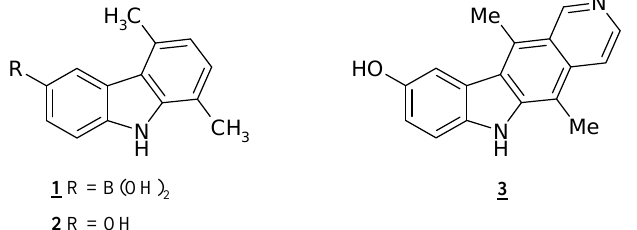
Figure 1 . Carbazol-3-yl boronic acid 1 , its 3-hydroxy derivative 2 and hydroxyellipticine ( 3